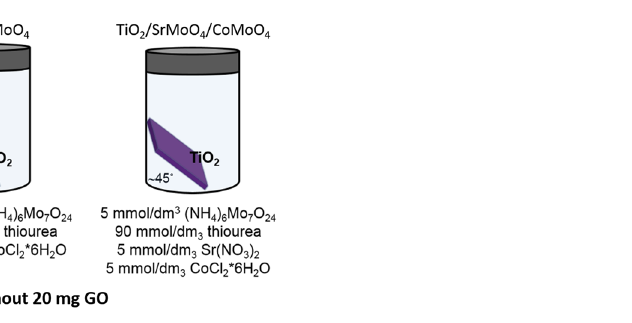
Figure 9. Reagents used in the hydrothermal method and their